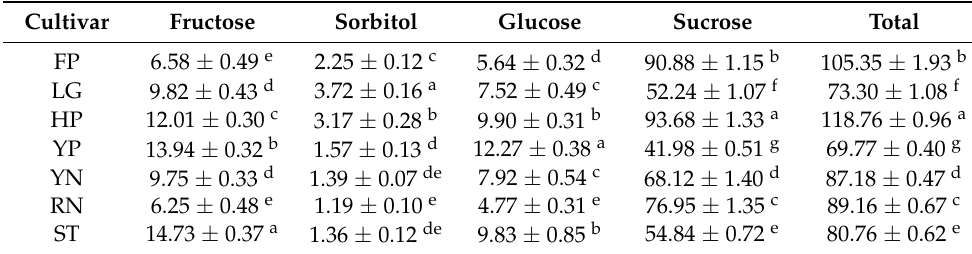
Table 3. Sugars (mg/g) in flesh of the seven peach